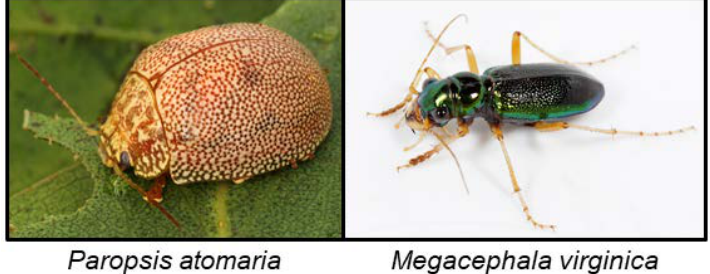
Figure 12. P. atomaria photo by Martin Lagerwey (https://commons.wikimedia.org/wiki/File:Paropsis_atomaria_Warby_Ranges2.JPG) and M. virginica photo by Patrick Coin (http://hasbrouck.